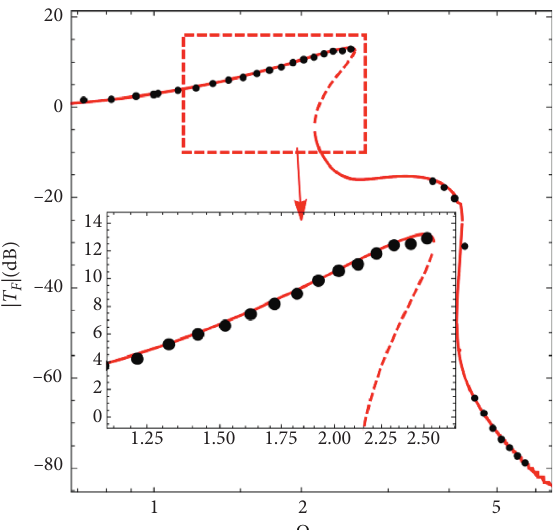
Figure 7: Force transmissibility when μ � 0 . 2, ζ Solid line , stable solution by the EHBM; dashed line , unstable solution by the EHBM; dot , numerical